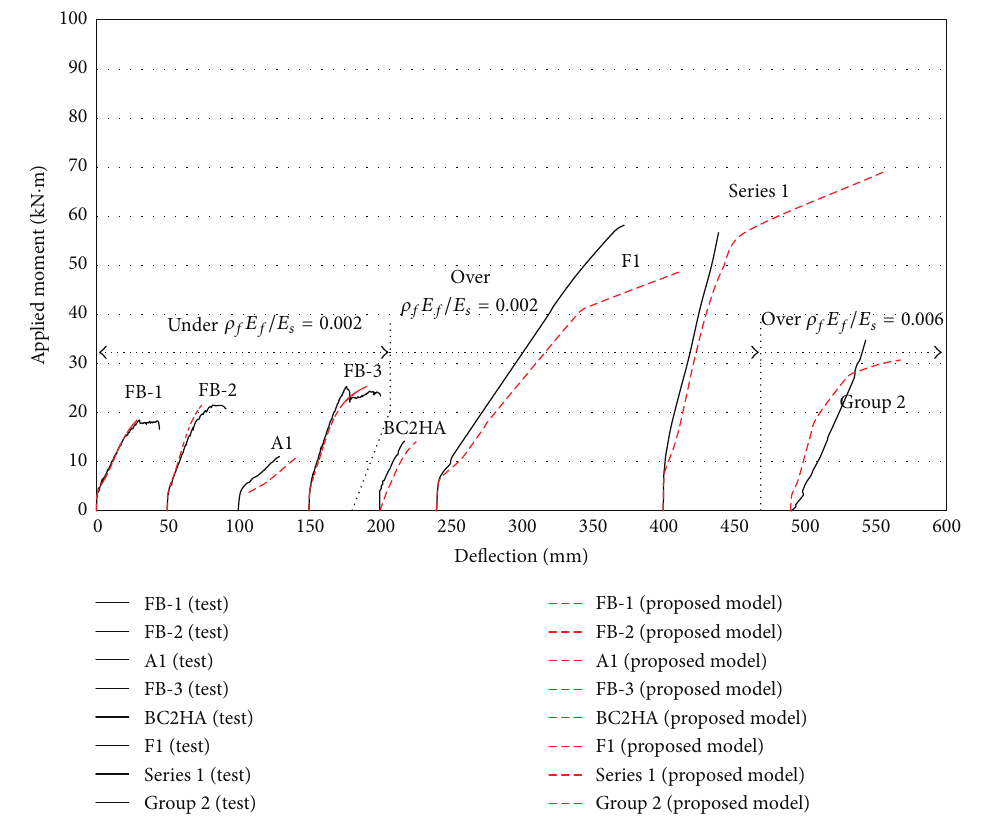
Figure 11: Comparison results between experimental tests and the proposed